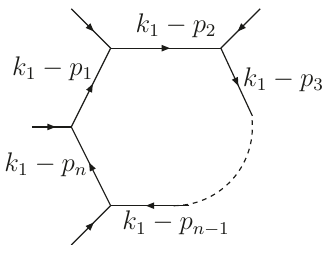
Figure 1 . The generic n -point one-loop